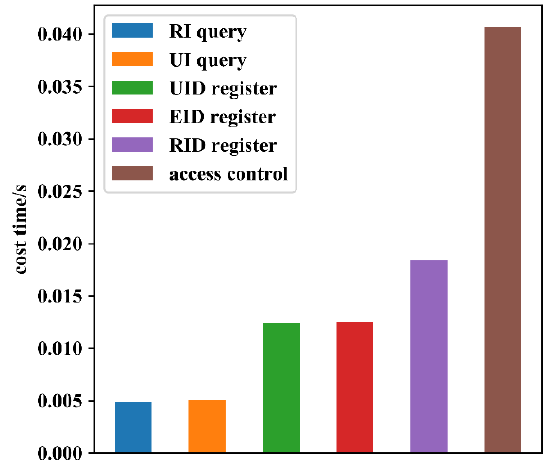
Figure 15. Time cost of a single smart gateway for processing various types of requests.